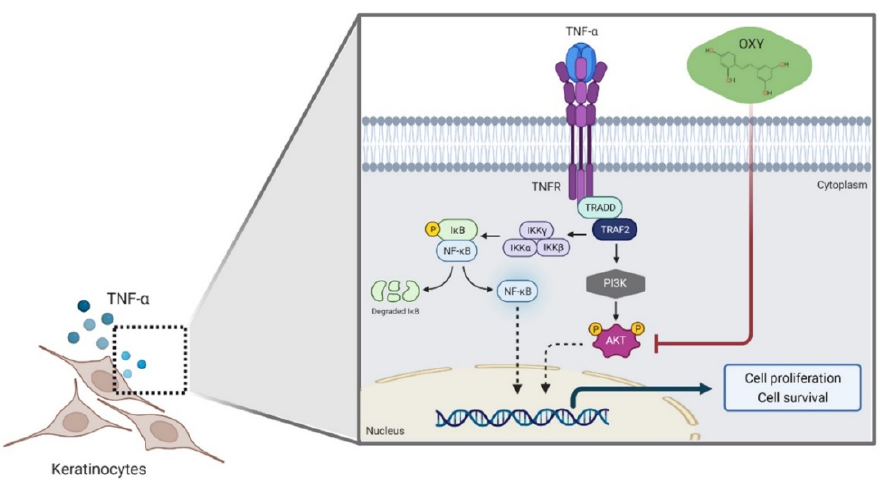
Figure 9. Illustrative picture presenting that OXY regulates TNF- α -induced immune response by inhibiting the activation of the PI3K/AKT signaling cascade, leading to a decrease in cell proliferation and survival. The graphic was created with BioRender.com (accessed on 25 November 2021).